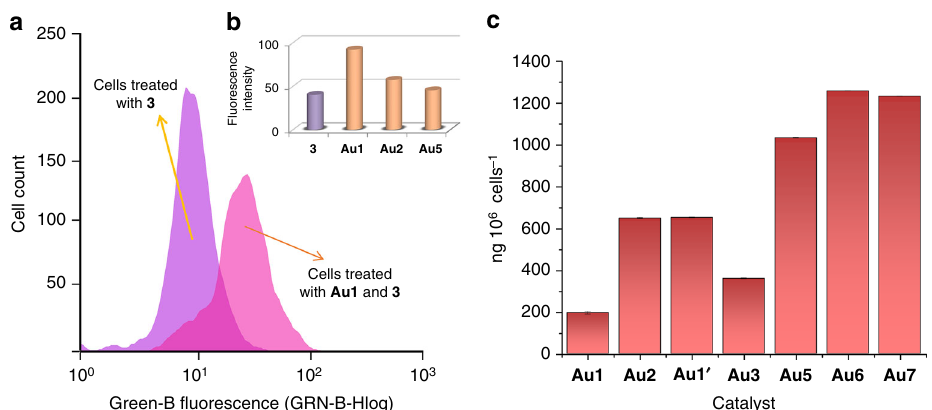
Fig. 4 Flow cytometry and ICP studies with gold complexes in HeLa cells. a Histogram showing a population of cells treated with substrate (pale purple) versus cells pretreated with Au1 and then incubated with substrate 3 (pink). b Quanti fi cation of fl uorescent cells after the reactions promoted either by Au1 , Au2 or Au5 (pink bars). Reaction conditions: Cells were incubated with the gold complex (50 µ M) for 30 min, washed with DMEM and treated with substrate 3 (100 µ M) for 6 h. c ICP-MS results on the intracellular accumulation of gold after incubation of cells in DMEM with 75 µ M of gold complexes (in DMSO) for 2 h, double washing with PBS and digestion with HNO